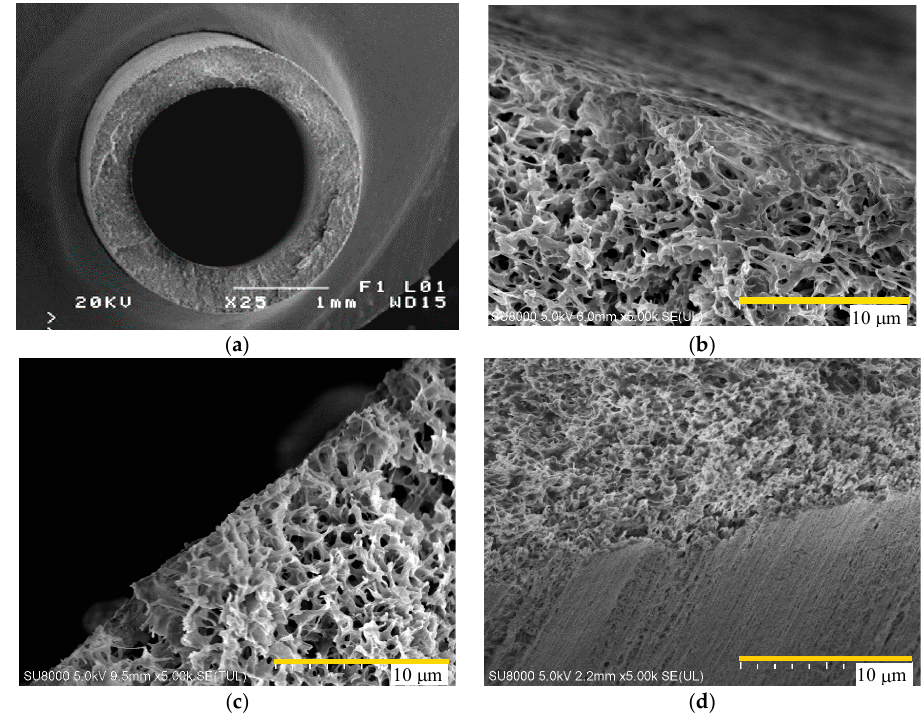
Figure 5. SEM images of membrane cross ‐ sections: ( a ) Accurel PP S6/2; ( b ) Accurel PP S6/2; ( c ) K1800; and ( d ) EuroSep PP.